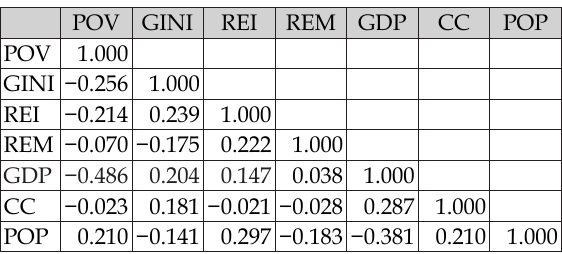
Table 3. Correlation results.